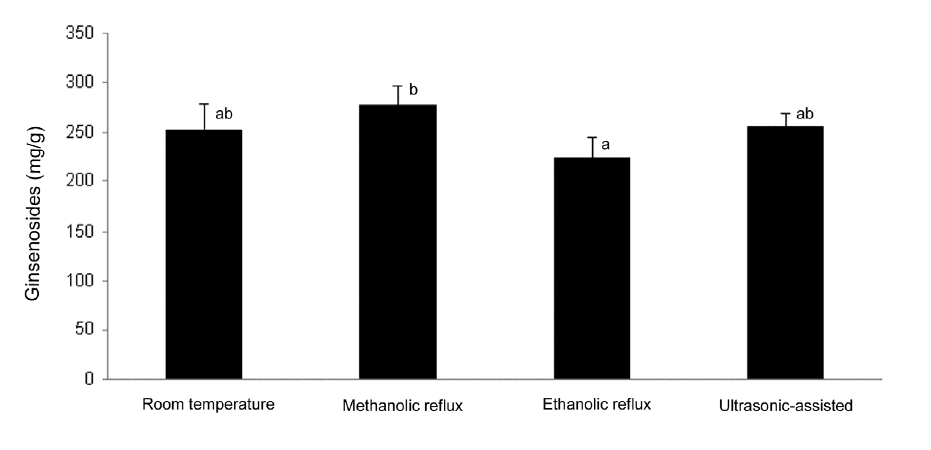
Figure 2 . Total ginsenoside content derived from various extraction methods. Columns with a different letter are significantly different ( P < 0.05).